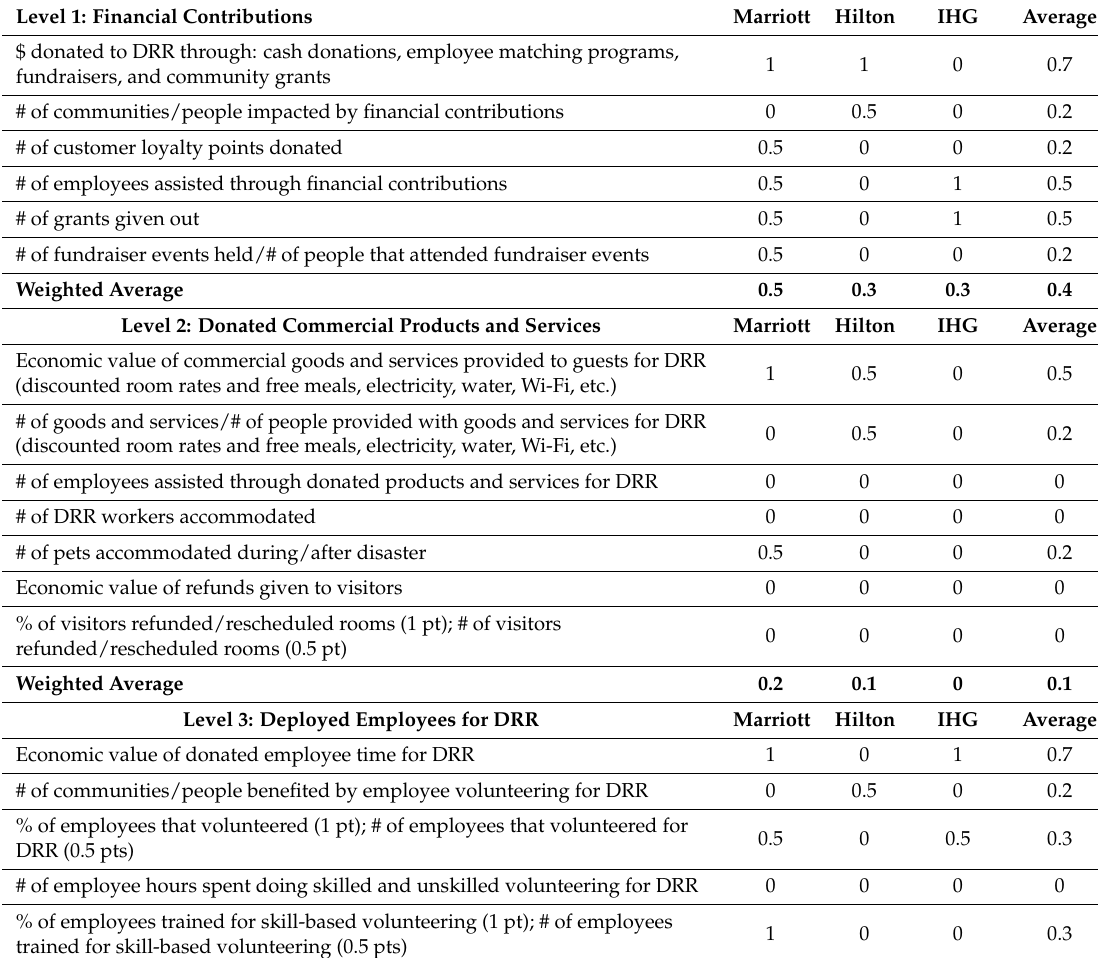
Table 2. Scoring breakdown for the metric analysis. NGO: non-governmental organization, SROI: Social Return on